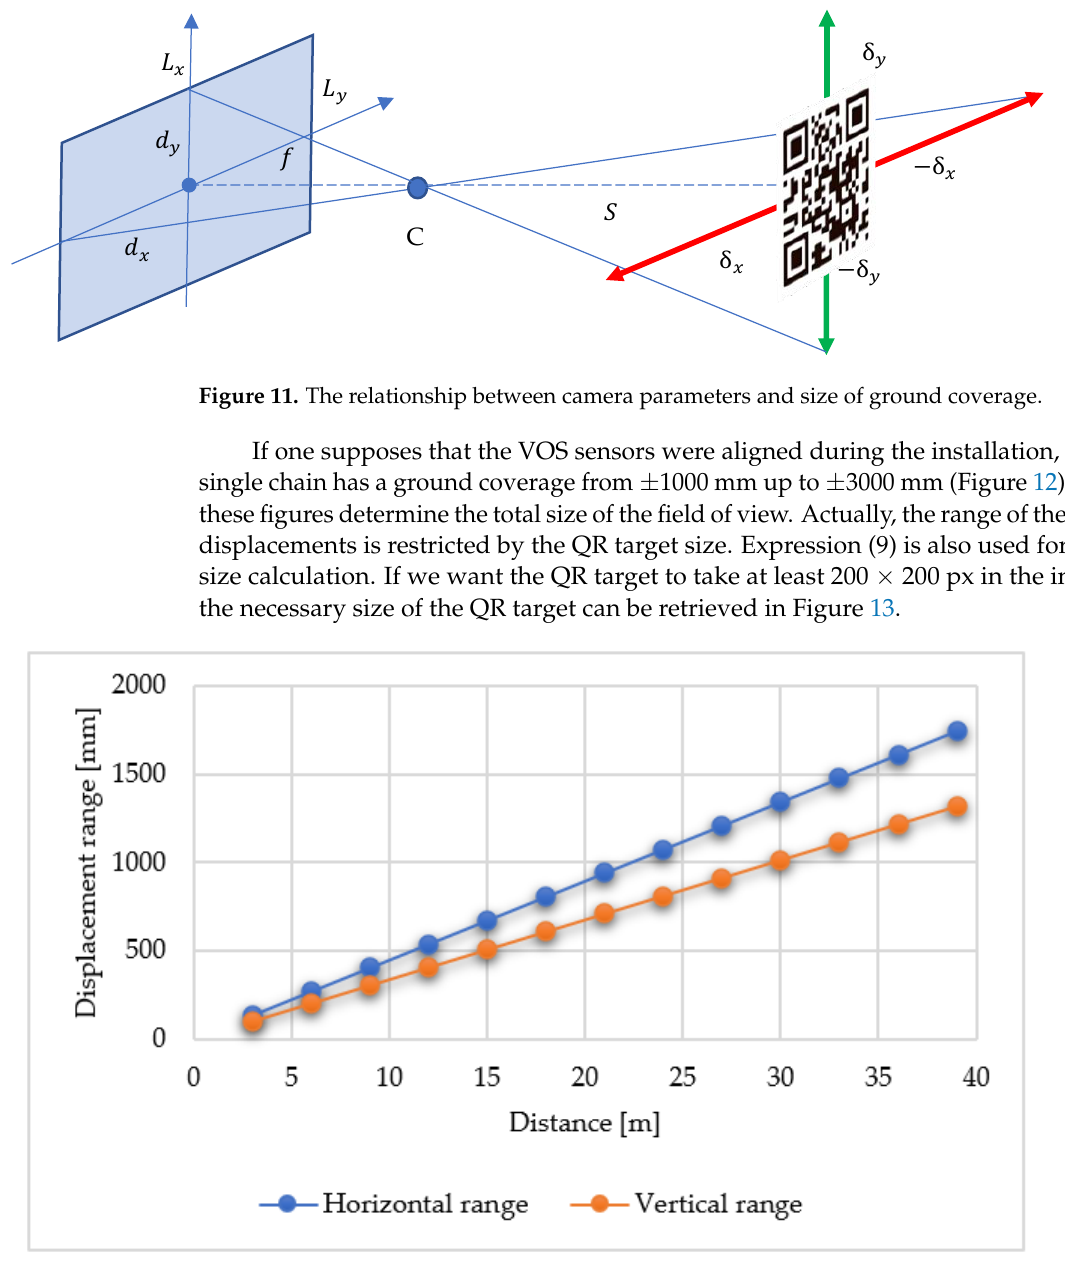
Figure 12. The relationship between camera parameters and size of ground